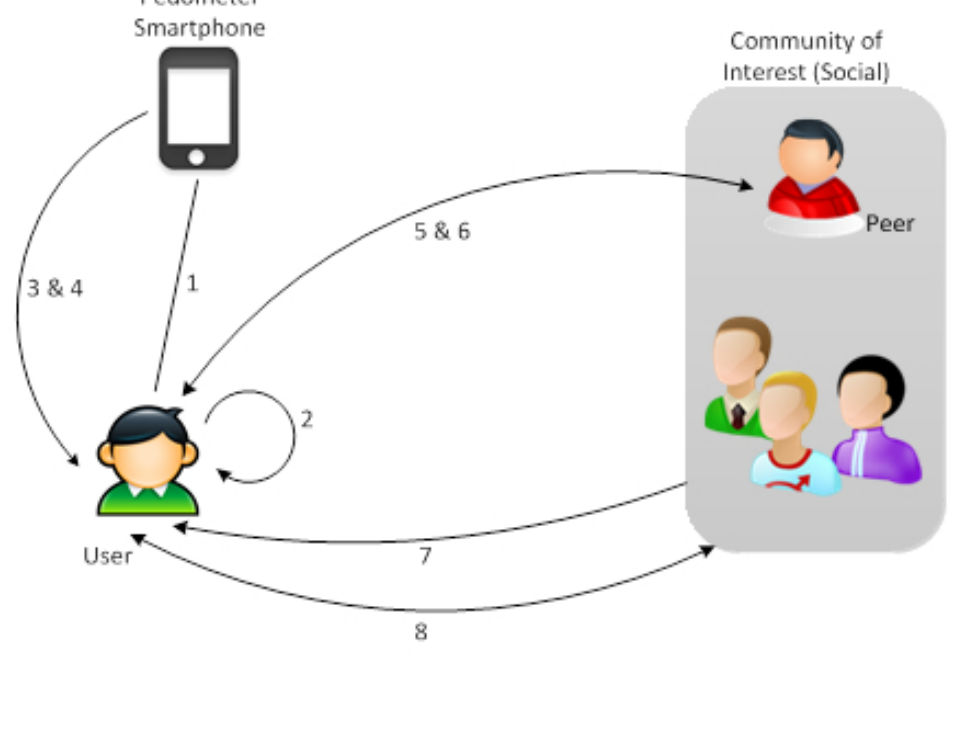
Figure 3. PersonA functional requirements. 1: self-measurement; 2: goal setting; 3: self-monitoring; 4: self-comparison; 5: peer support; 6: peer comparison - competition; 7: social support; 8: social comparison -